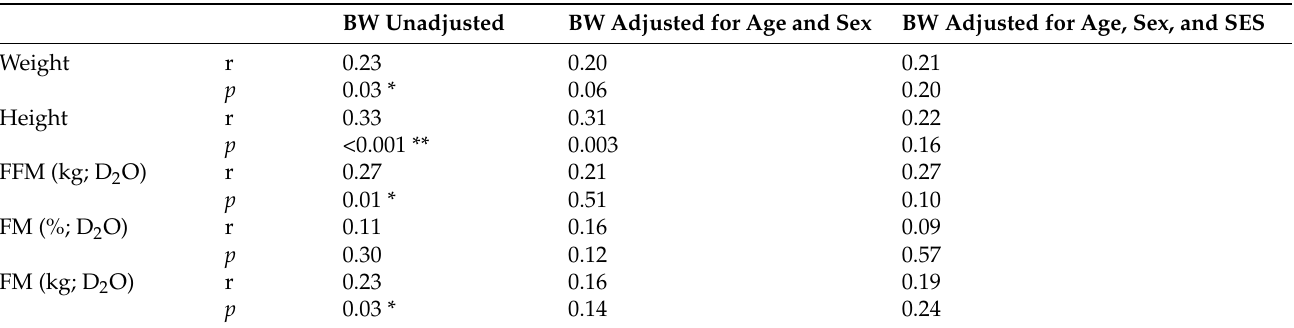
Table 4. Association between BW and body composition measures unadjusted and then adjusted for age, sex, and selected SES variables